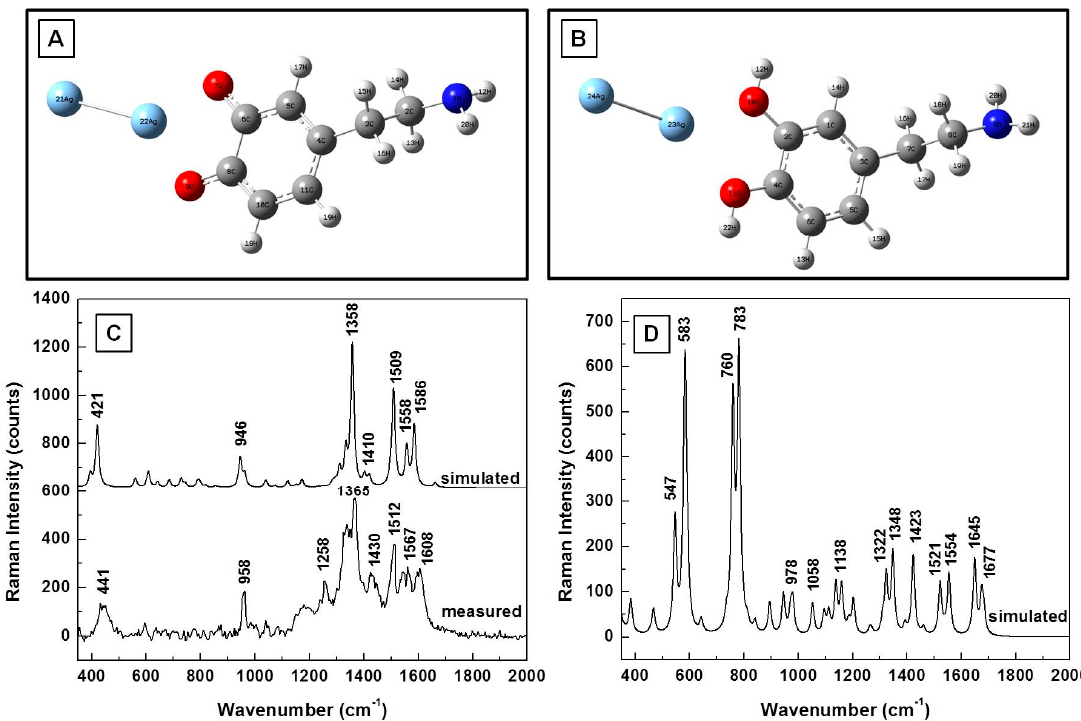
Figure 3. ( A , B ) Dopaminequinone and neutral DA 0 structural representations in the proximity of a silver dimer after energy optimization, respectively; ( C ) Theoretically estimated and experimentally recorded Raman vibrational spectra of dopaminequinone; ( D ) Theoretically calculated Raman spectrum of dopamine in the proximity of silver.